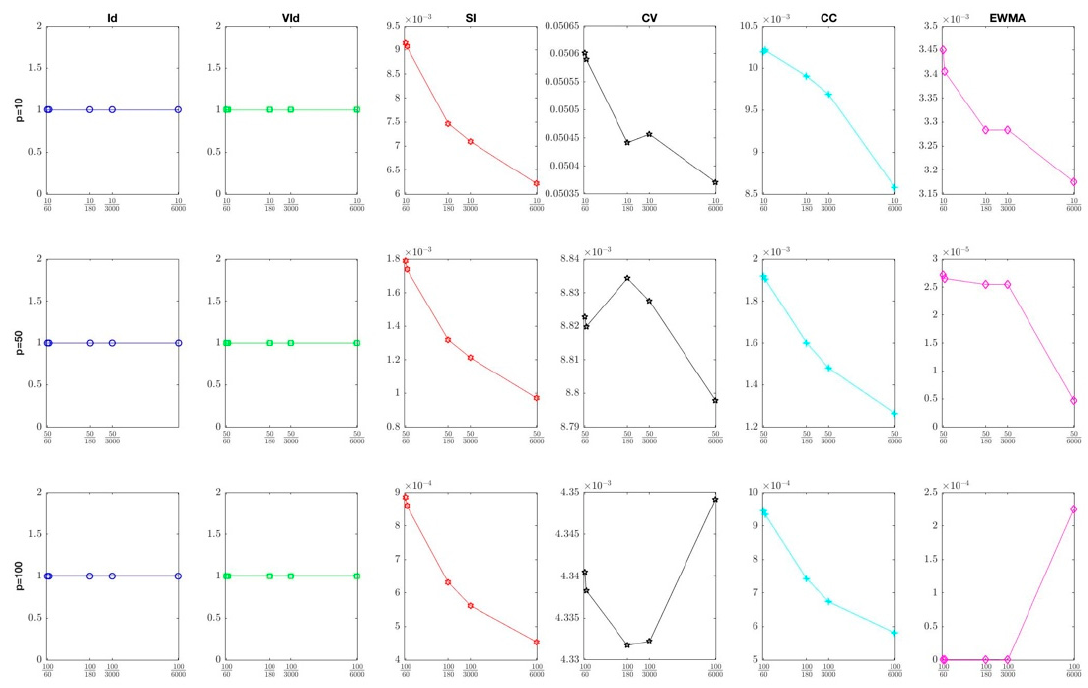
Figure 2. The reciprocal 1-norm condition number (y-axis) as the p / n ratio moves from p (x-axis). Each column corresponds to a specific target matrix: from left to right, the Identity (Id): blue circle-shaped; the Variance Identity (VId): green square-shaped; the Single-Index (SI): red hexagram-shaped; the Common Covariance (CV): black star-shaped; the Constant Correlation (CC): cyan plus-shaped; and the Exponential Weighted Moving Average (EWMA): magenta diamond-shaped, respectively. Each row corresponds to a different p : in ascendant order from 10 (first row) to 100 (third row).